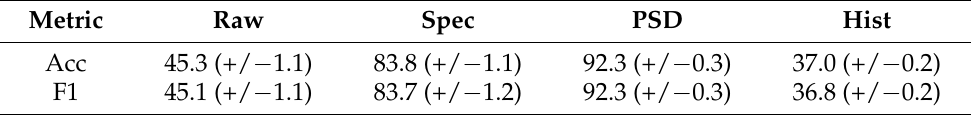
Table 2. UAV Classification Accuracy (%) and F1-Score